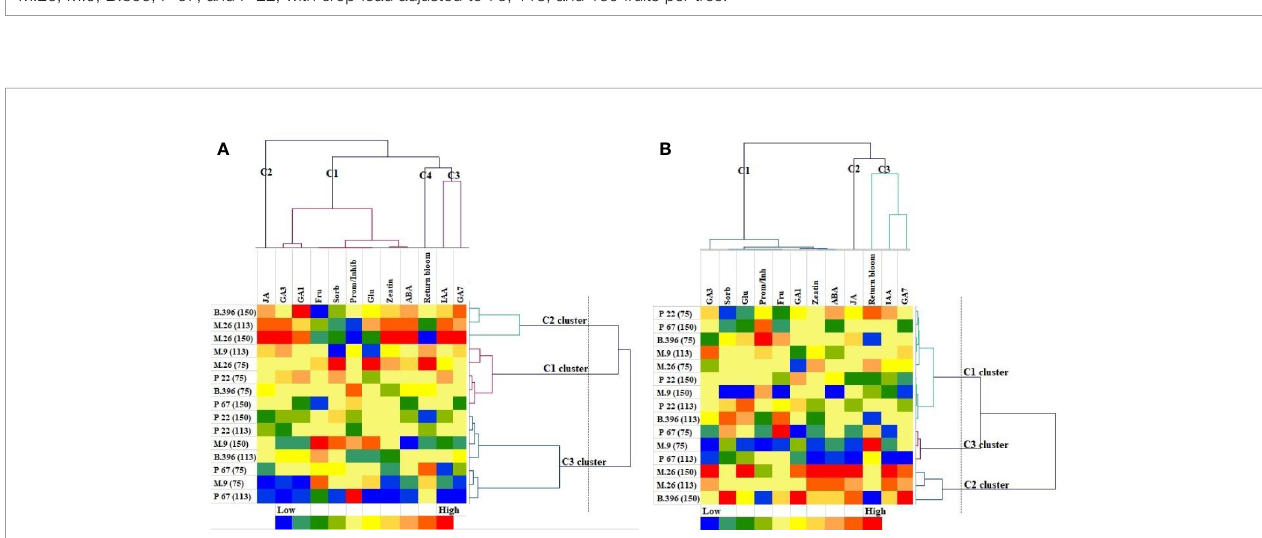
FIGURE 4 | Agglomerative hierarchical cluster (AHC) analysis in “ Ligol ” (A) and “ Auksis ” (B) . Phytohormones, soluble sugars and return bloom grouped by similarities in concentration mean and intensity values. The analysis was conducted with all data resulting from 9 trees of “ Ligol ” and “ Auksis ” apple trees grafted on M.26, M.9, B.396, P 67, and P 22, with crop-load adjusted to 75, 113, and 150 fruits per